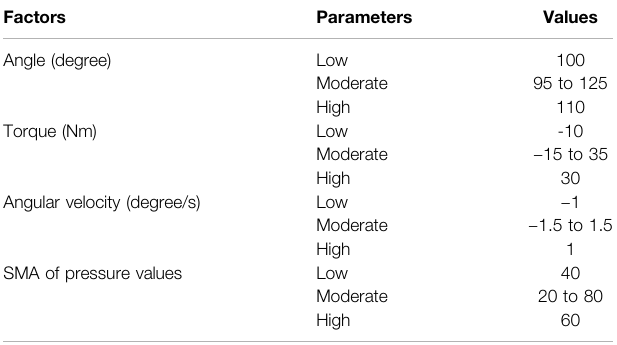
TABLE 2 | Care training quantitative assessment